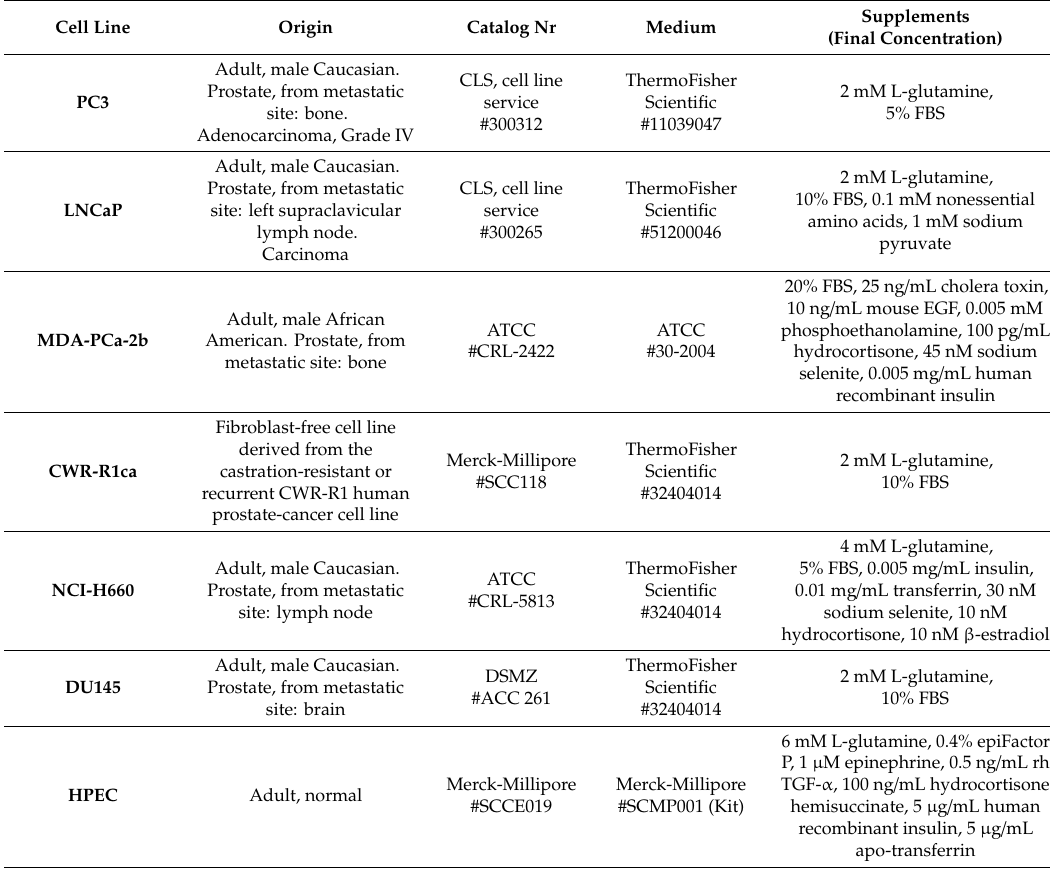
Table 1. Characteristics of the cell lines used in the study. If not otherwise specified, fetal bovine serum (FBS) was purchased from Bio&SELL (FBS Superior, #S 0615, Feucht,